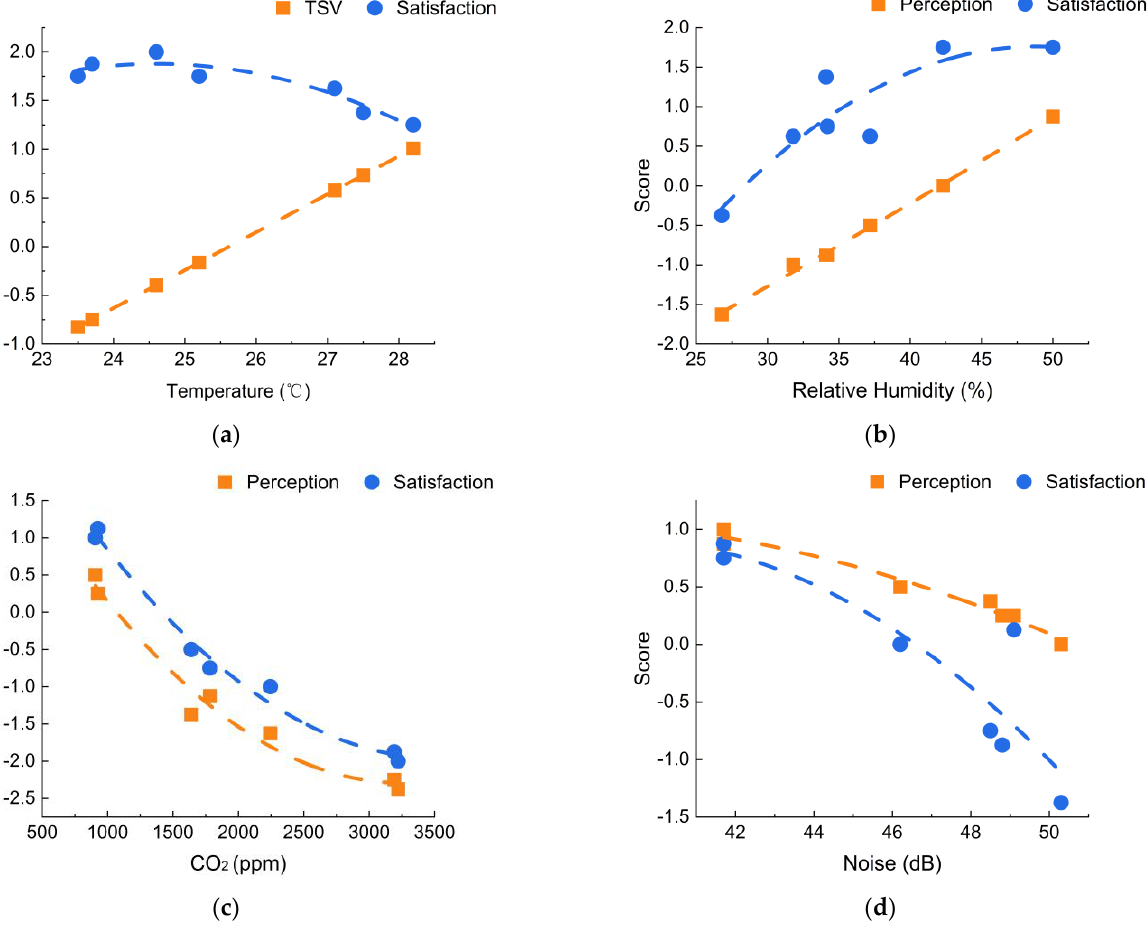
Figure 13. Associations between ( a ) temperature; ( b ) RH; ( c ) CO 2 ; ( d ) noise and corresponding environmental perception and satisfaction scores.